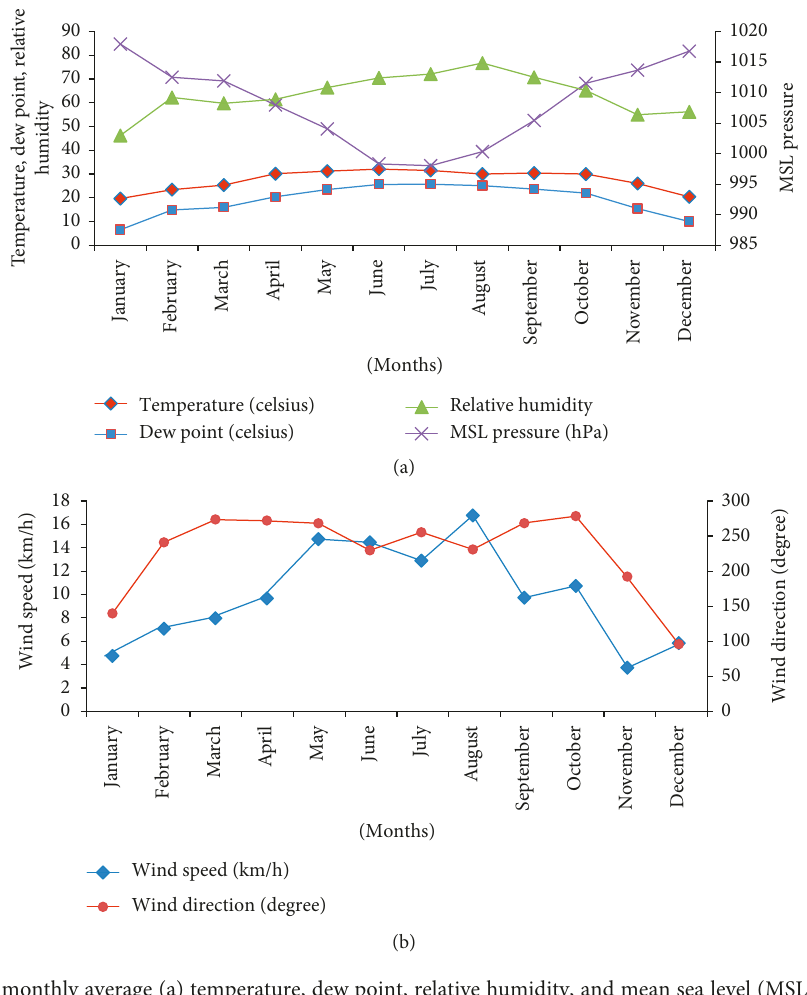
Figure 2: Variability of monthly average (a) temperature, dew point, relative humidity, and mean sea level (MSL) pressure, and (b) wind speed and wind direction over Karachi during the study period.